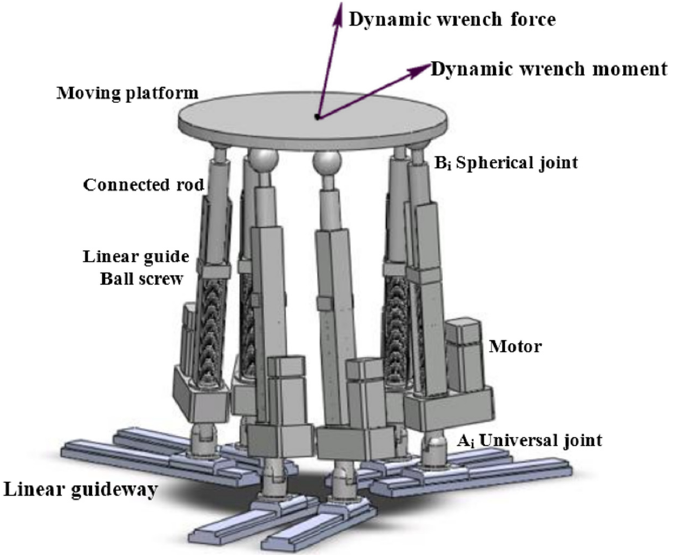
Figure 1. Geometric structure of a reconfigurable motor ‐ driven parallel robot.